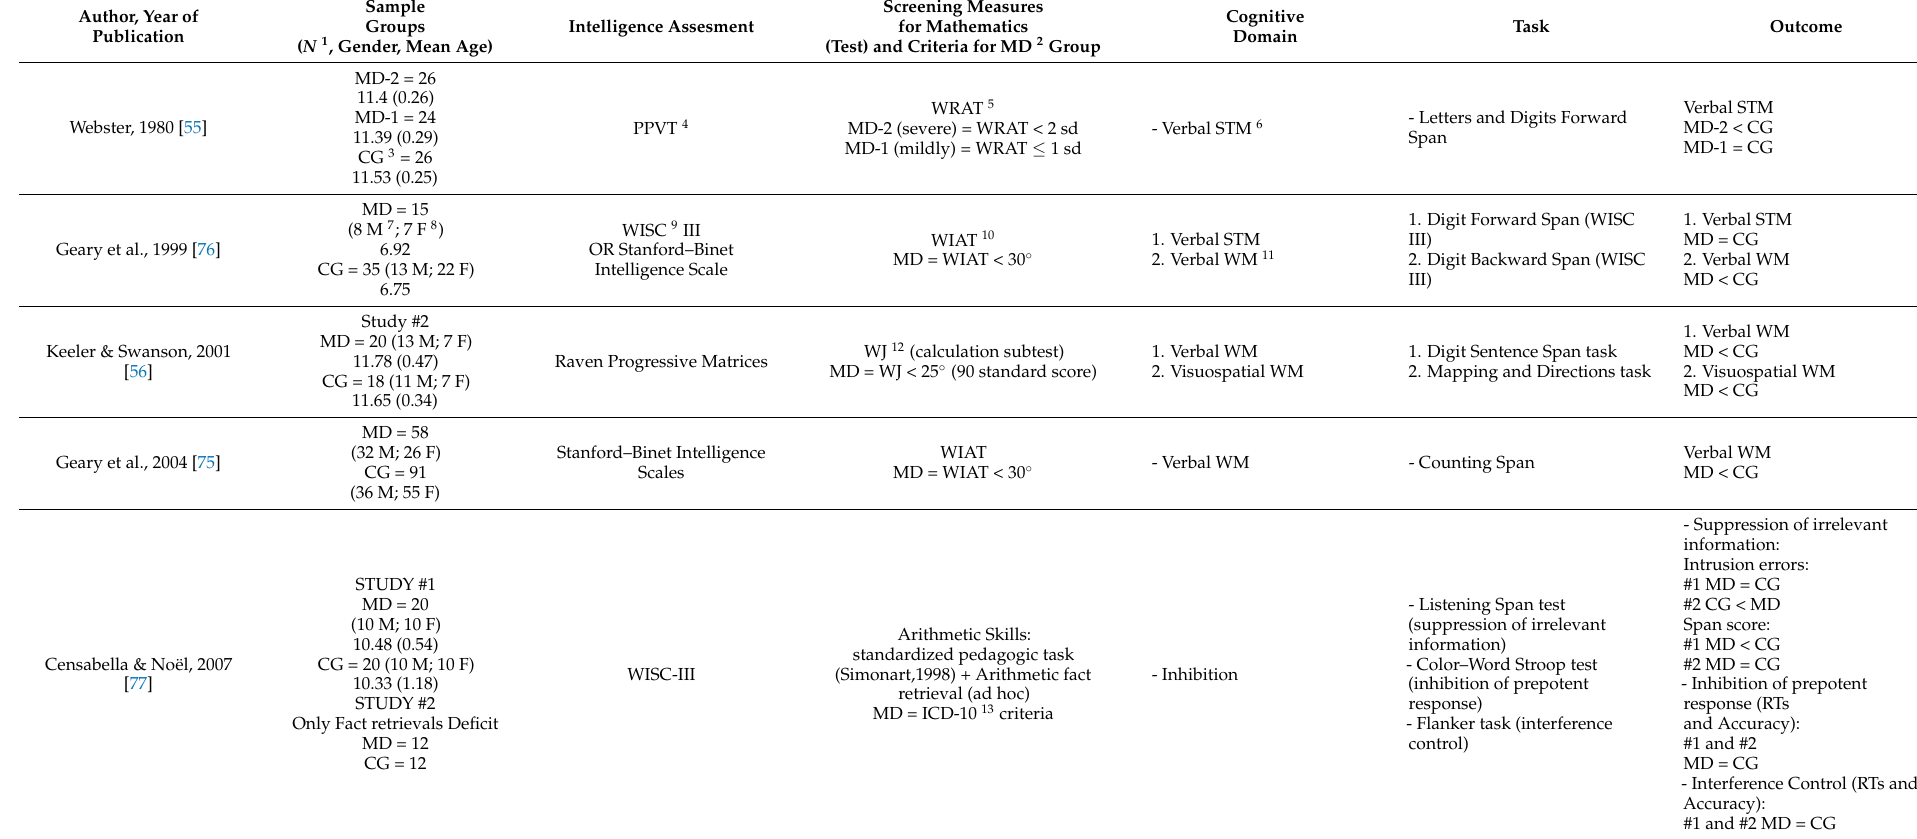
Table A1. Characteristics of the cross-sectional